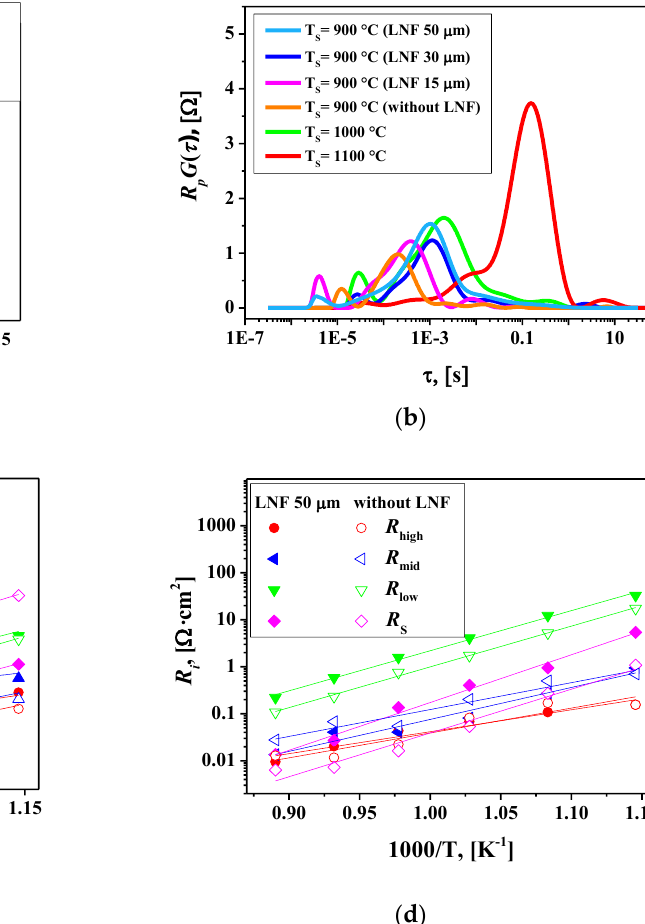
Figure 10. ( a ) Electrode polarization resistance versus temperature for different La 1.7 Ca 0.3 Ni 0.6 Cu 0.4 O 4+δ /SDC cells; ( b ) DFRTs calculated by the regularization method at 800 °C; ( c ) partial contributions to R p for the La 1.7 Ca 0.3 Ni 0.6 Cu 0.4 O 4+δ /SDC cells fabricated at 1000 °C and 1100 °C; ( d ) partial contributions to R p for the La 1.7 Ca 0.3 Ni 0.6 Cu 0.4 O 4+δ /SDC cells fabricated at 900 °C with and without the LNF collector layer.